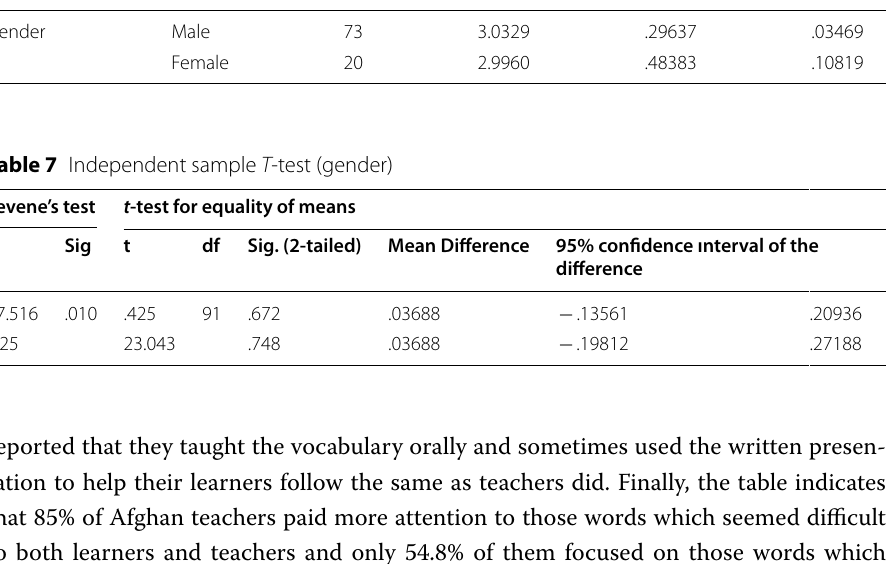
Table 6 Descriptive statistics (gender) Variable